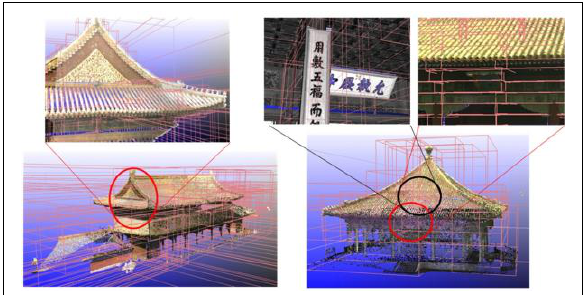
Figure 6 Overall visualization of point image